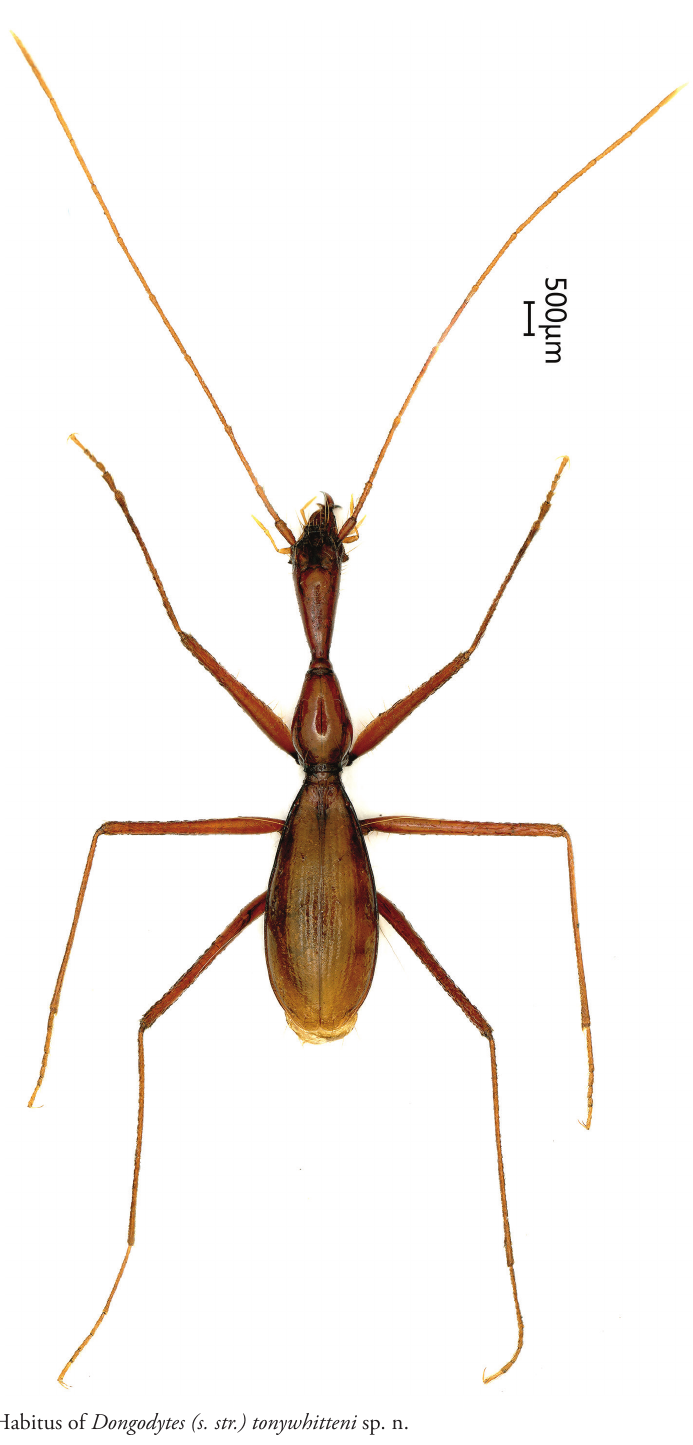
Figure 4. Habitus of Dongodytes (s. str.) tonywhitteni sp.